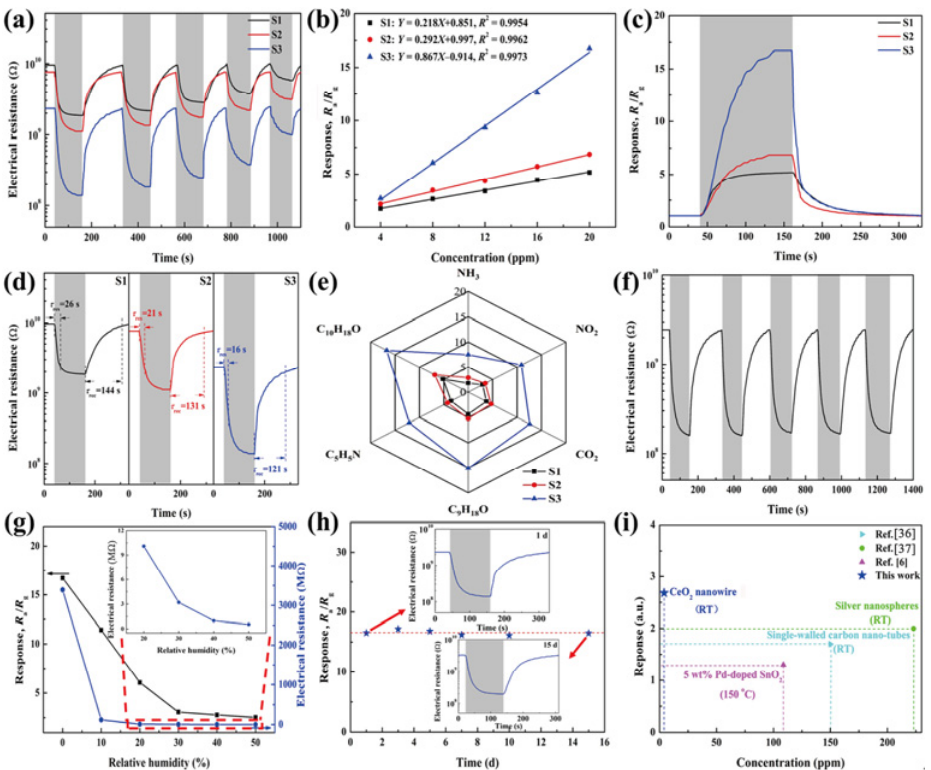
Fig. 5 (a) Changes in electrical resistance towards different concentrations of ppm-level linalool at RT; (b) linear relationship between response and concentrations (4–20 ppm); (c) responses and (d) dynamic response–recovery curves of S1, S2, and S3 to 20 ppm linalool; (e) responses of S1, S2, and S3 to 20 ppm different target gases; (f) reproducibility of S3 to 20 ppm linalool; (g) response and electrical resistance of S3 to 20 ppm linalool under various RH; (h) long-term stability of S3 to 20 ppm linalool; and (i) gas-sensing performance in comparison with other state-of-the-art linalool